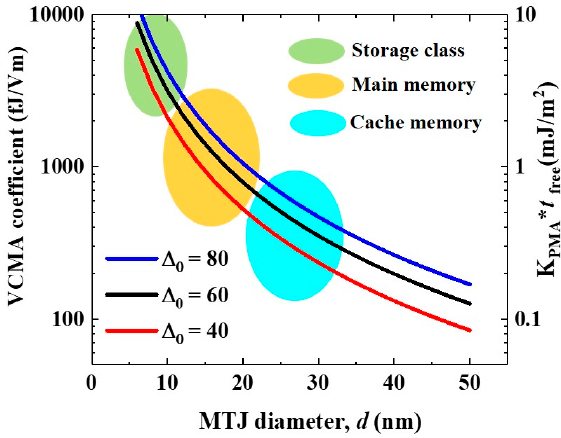
Figure 10. Scalability issue for voltage-torque MRAMs. The dependence of the required K PMA t free and VCMA coefficient on the diameter of the MTJ was estimated for each thermal stability factor ( Δ 0 ).